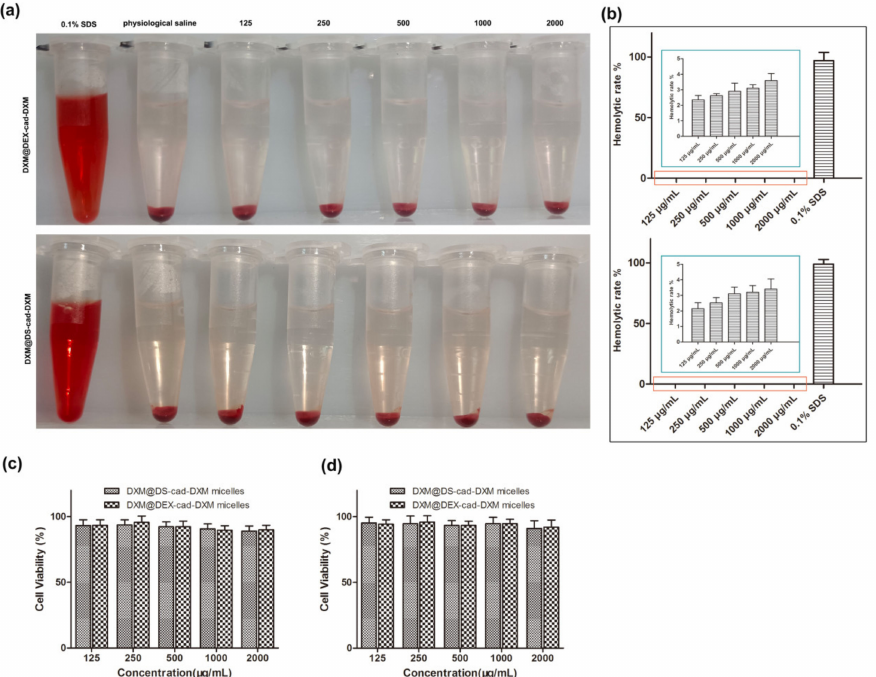
Figure 3. Hemolysis images ( a ) and statistics result ( b ) of DXM@DS-cad-DXM micelles and DXM@DEX-cad-DXM micelles. Cytotoxicity of DXM@DS-cad-DXM micelles and DXM@DEX-cad- DXM micelles on RAW264.7 cells ( c ) and HUVEC cells ( d ). All data are presented as mean ± SD (n =